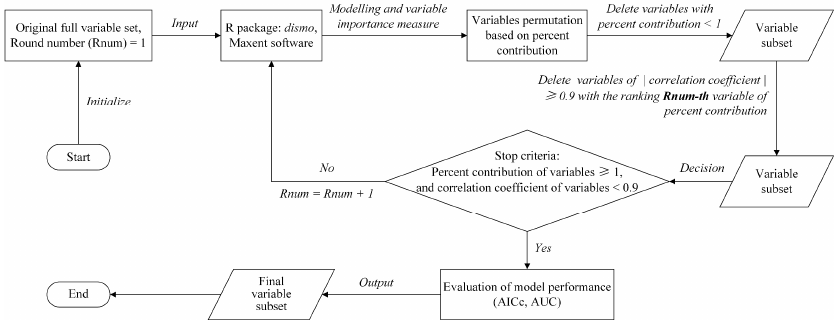
Figure 2. Workflow of the variable selection based on variable importance and correlation for the Maxent models.